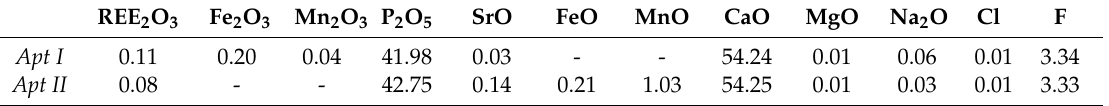
Table 8. Elemental median concentration values (wt %) characterizing each apatite generation.